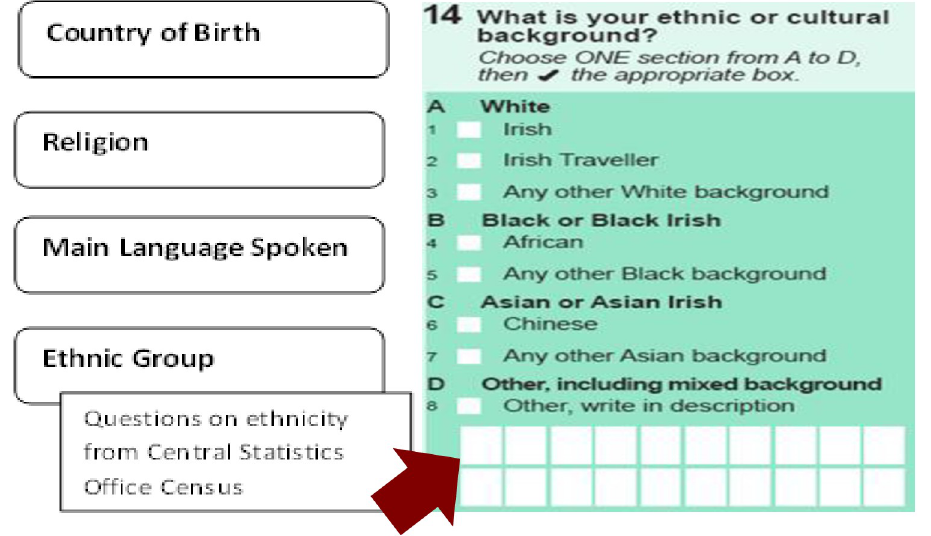
Fig 1. Irish Health Service Executive ethnic